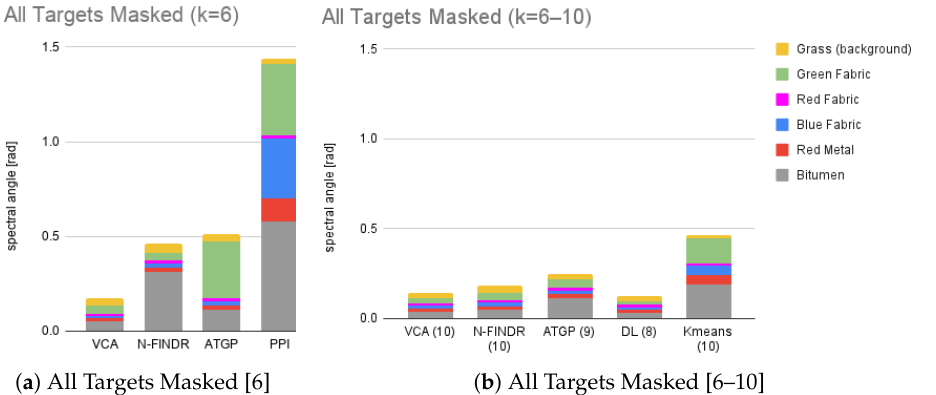
Figure 8. SISAL iterations shown in a two-dimensional projection of the spectral parameter space for the Small Targets subset. The blue dots represent the data points and the red ones the endmembers identified in consecutive iterations up to convergence to the chosen solution shown as green dots.